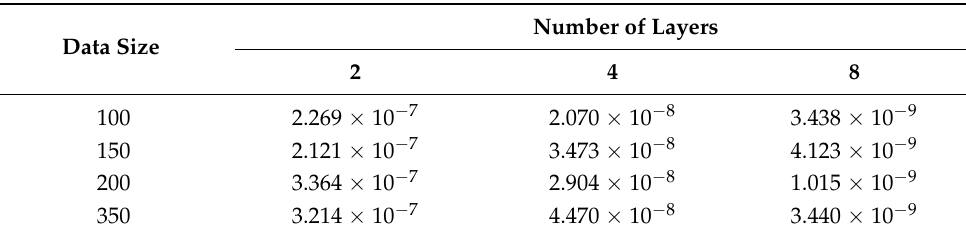
Table 3. Results of the mean square error analysing of varying sizes of data points and number of layers in the simulations.